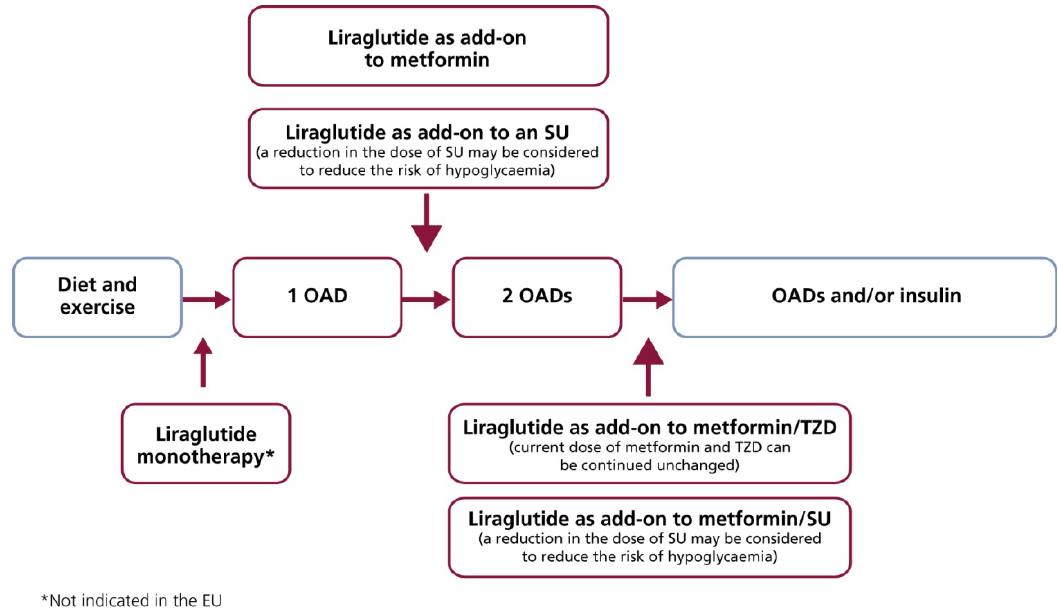
Figure 13. Liraglutide Potential Use in Clinical Practice, as Evidenced by the LEAD